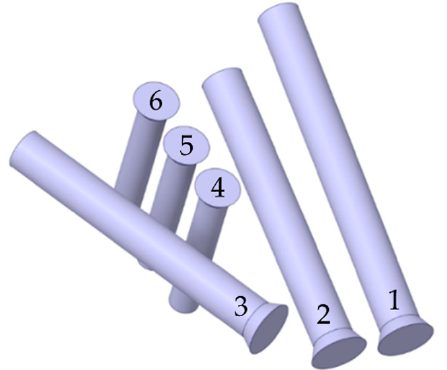
surgery. surgery.